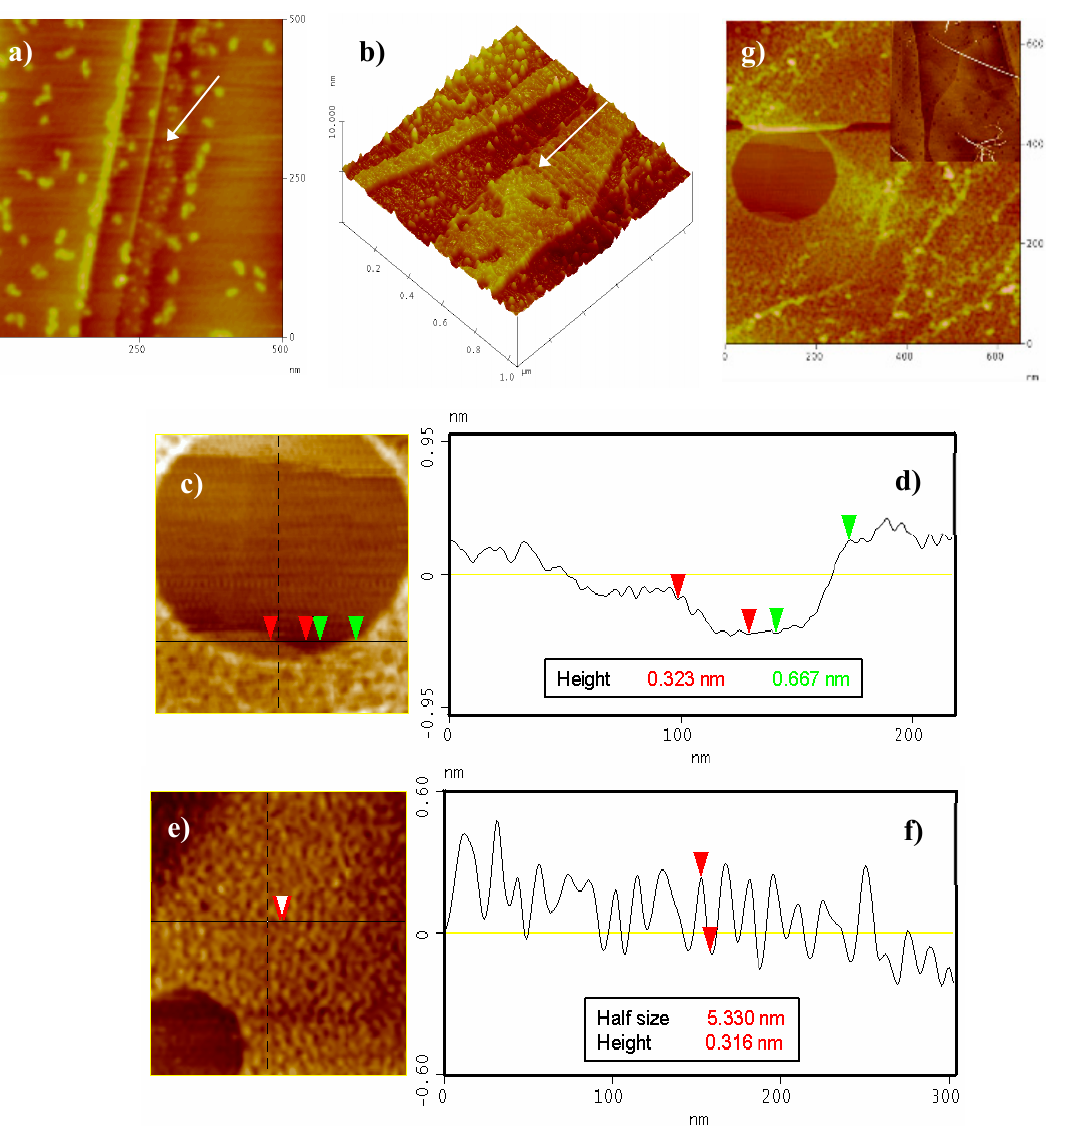
Figure 9. AFM images of pyrolytic graphite (HOPG) after di ff erent times of immersion into a G1 10 − 5 M water solution. ( a ) 420 nm × 420 nm, t = 5 min, ( b ) 1.1 µ m × 1.1 µ m 3D, t = 5 min, ( c ) 220 nm × 220 nm, t = 10 min and ( d ) corresponding cross-section shows the first layer (red arrows) and the second layer (green arrows). ( e ) 300 nm × 300 nm, t = 10 min and ( f ) cross-section showing the overlayer morphology. ( g ) 620 nm × 620 nm, t = 10 min. Inset: 2.8 µ m × 2.8 µ m, t = 5 min, G1 10 − 4 M.